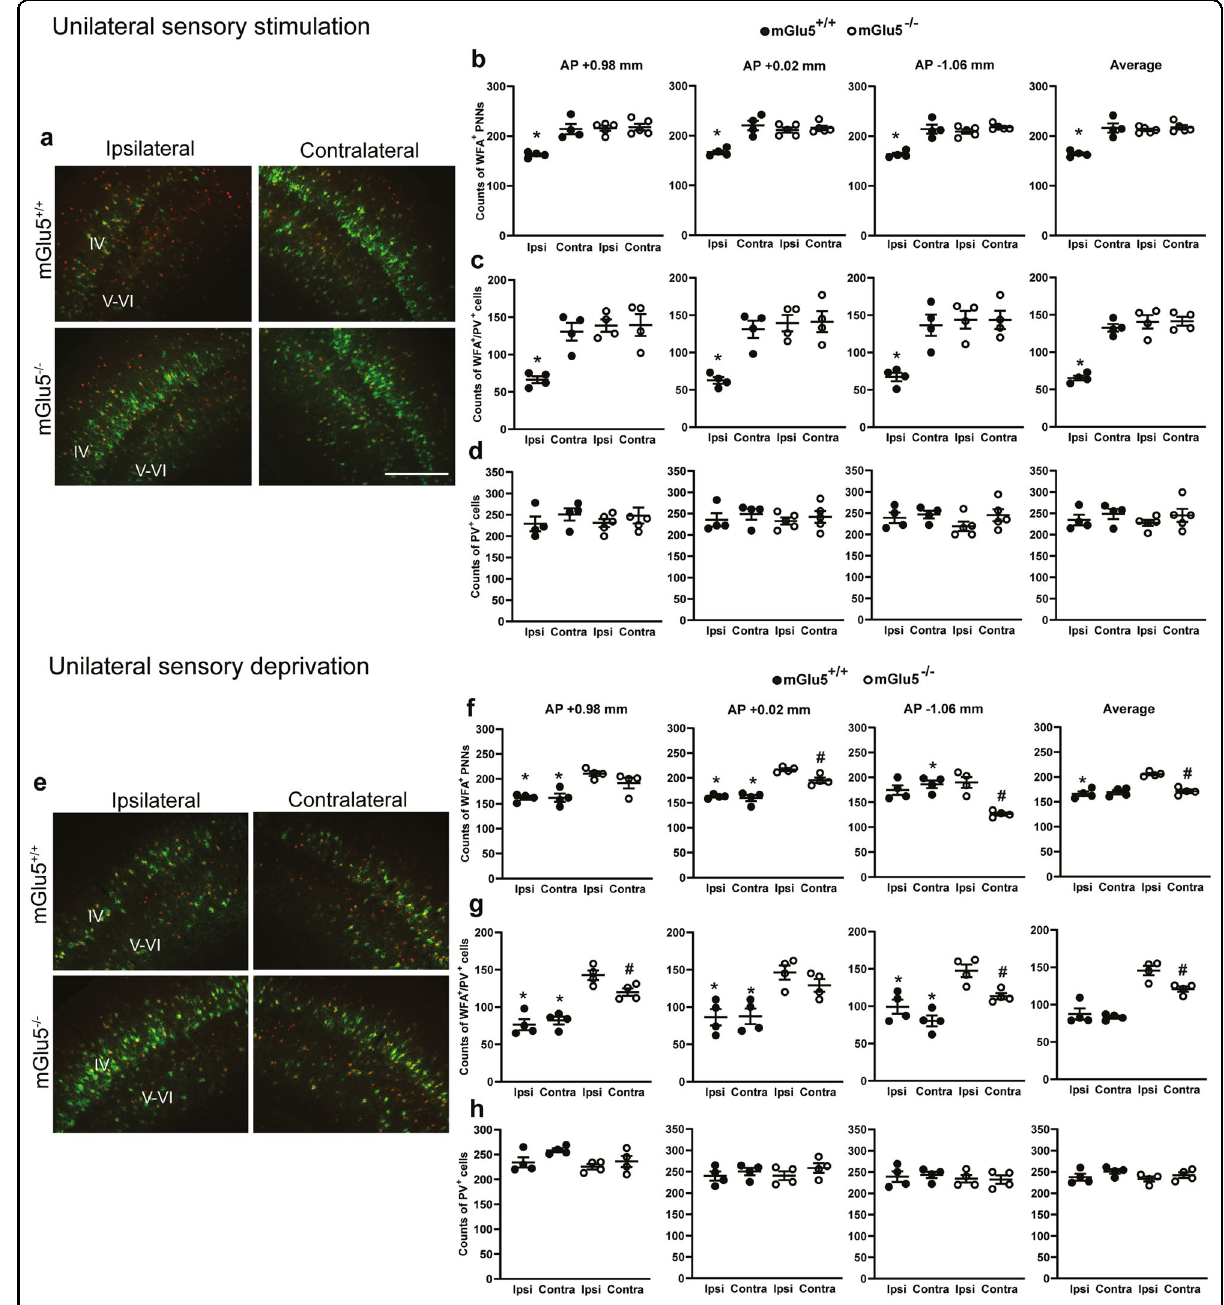
Fig. 5 mGlu5 receptors shape the PNN response to sensory experience in the somatosensory cortex at PND16. a – d WFA + , WFA + /PV + , and PV + cell density in the ipsilateral (Ipsi) or contralateral (Contra) somatosensory cortex of mGlu5 + / + and mGlu5 − / − mice after unilateral whisker stimulation from PND9 to PND16. a green = WFA and red = PV; scale bar = 100 μ m. b , c *statistically signi fi cant vs the respective contralateral side. Immunostaining in c and d was performed in sections adjacent to levels indicated in b . e – h WFA + , WFA + /PV + and PV + cell density in the ipsilateral (Ipsi) or contralateral (Contra) somatosensory cortex of mGlu5 + / + and mGlu5 − / − mice after unilateral whisker trimming from PND9 to PND16. e green = WFA and red = PV; scale bar = 100 μ m. f , g statistically signi fi cant vs the respective side in mGlu5 − / − mice (*) or vs the ipsilateral side of mGlu5 − / − mice (#). Immunostaining in g and h was performed in sections adjacent to levels indicated in f . Statistical analysis was performed by two- way ANOVA followed by Bonferroni post hoc test. All F values are in the Supplementary